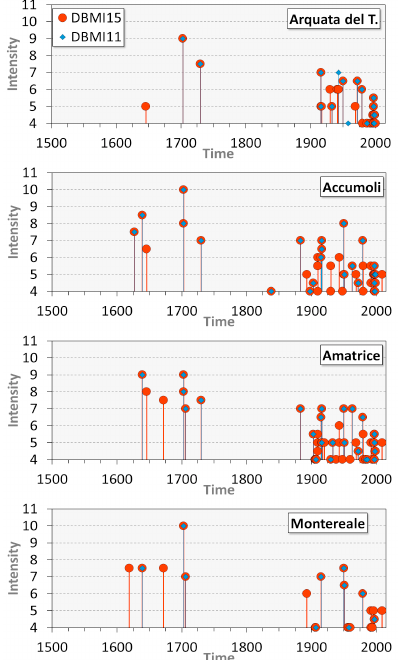
Figure 2: Comparison between seismic histories of Ar- quata del Tronto, Accumoli, Amatrice, and Montereale from DBMI11 [Locati et al., 2011], and the improved ones in